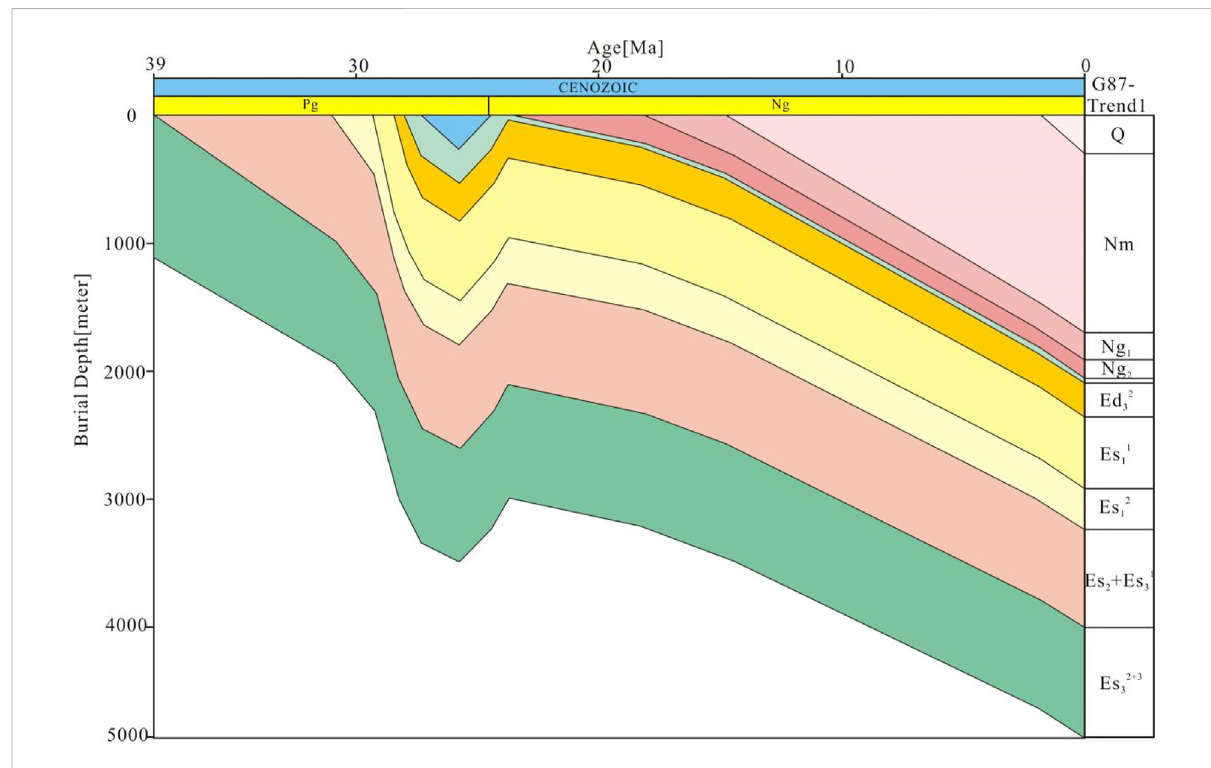
FIGURE 6 Burial history of Es 3 2+3 in well G87 in the Gaoshangpu oil fi